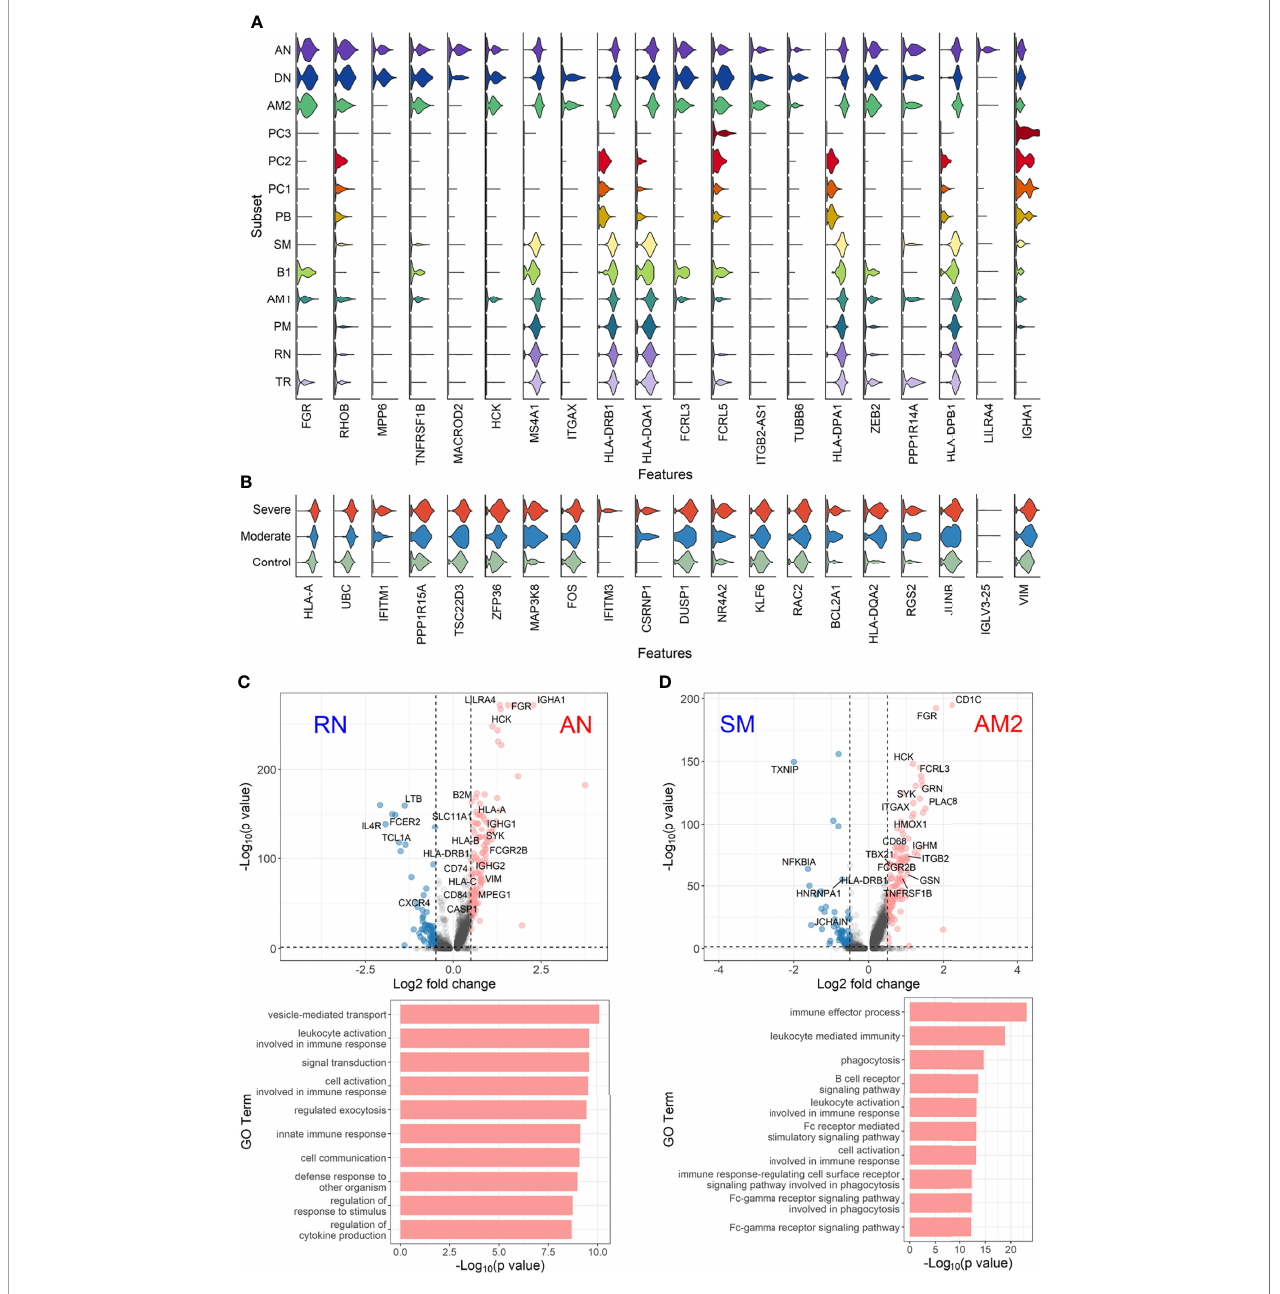
FIGURE 5 | Characterization of EF B-cell subsets. (A) Gene expression violin plots of the 20 most signi fi cant DEGs in three EF B-cell subsets (AN, DN, and AM2) in comparison with other B-cell subsets. (B) Violin plots of top 20 DEGs in the severe group across three EF B-cell subsets. Volcano plot and bar plot presenting signi fi cant DEGs and top 10 signi fi cant GO terms when compared between AN and RN B-cell subsets (C) , or between AM2 and SM B-cell subsets (D)